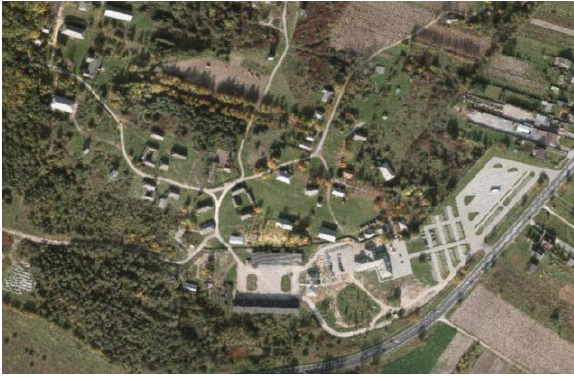
Figure 7. Orthophoto generated with 3 cm